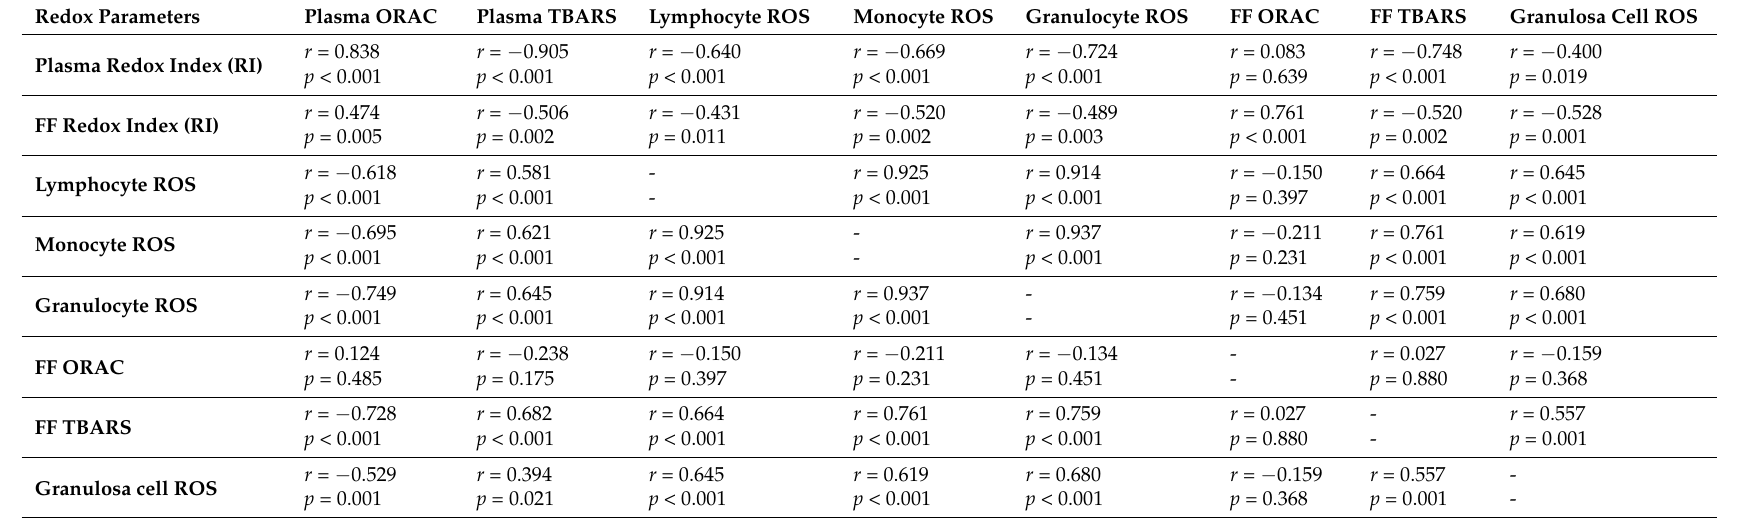
Table 1. Partial correlation coefficients between the investigated oxidative stress-related parameters after controlling for endometriosis, age, smoking habits, body mass index (BMI), in vitro fertilization-embryo transfer (IVF-ET)/intracytoplasmic sperm injection (ICSI), follicle stimulating hormone (FSH), luteinizing